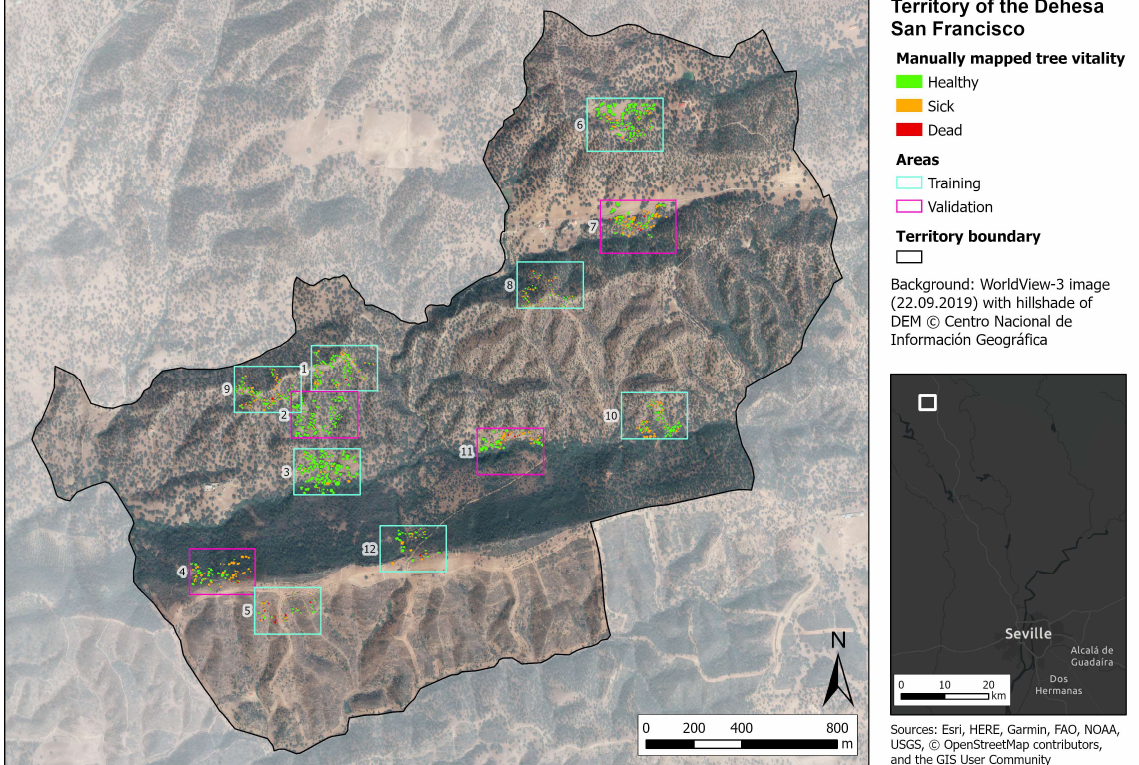
Figure 1. Study area with manually mapped tree vitality and allocation to training/validation areas for the